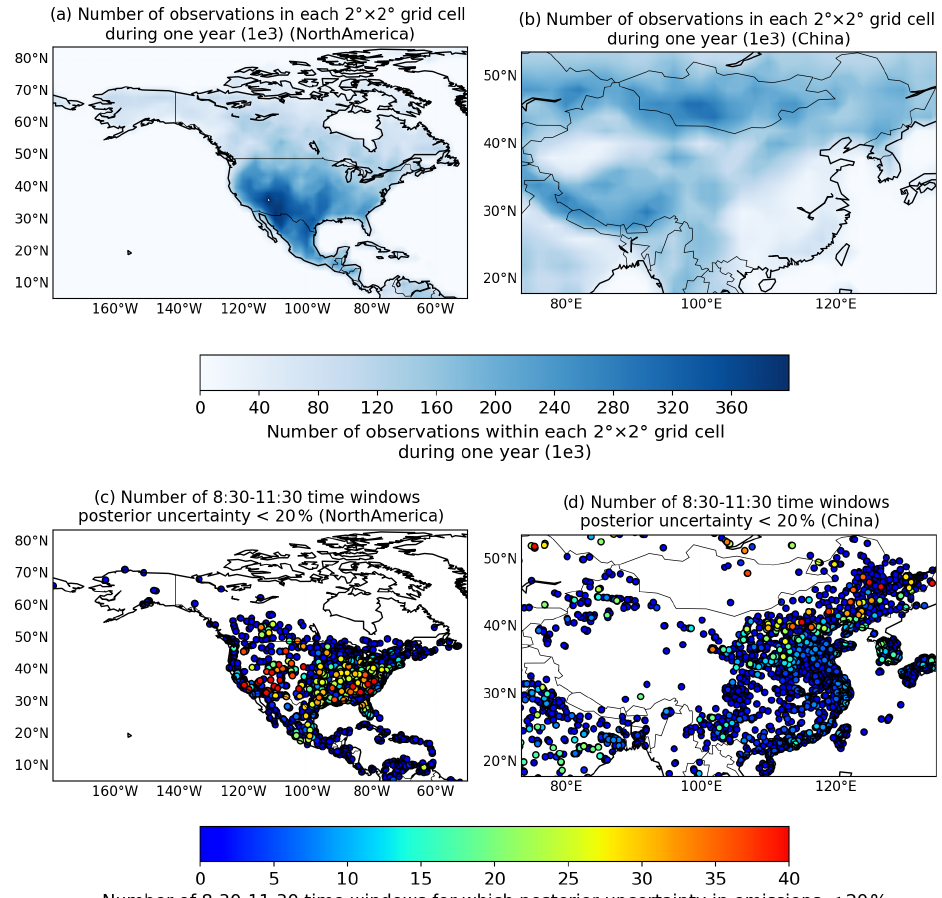
Figure 6. Number of observations in 2 ◦ × 2 ◦ grid cells during 1 year (a, b) and N20 values (c, d)